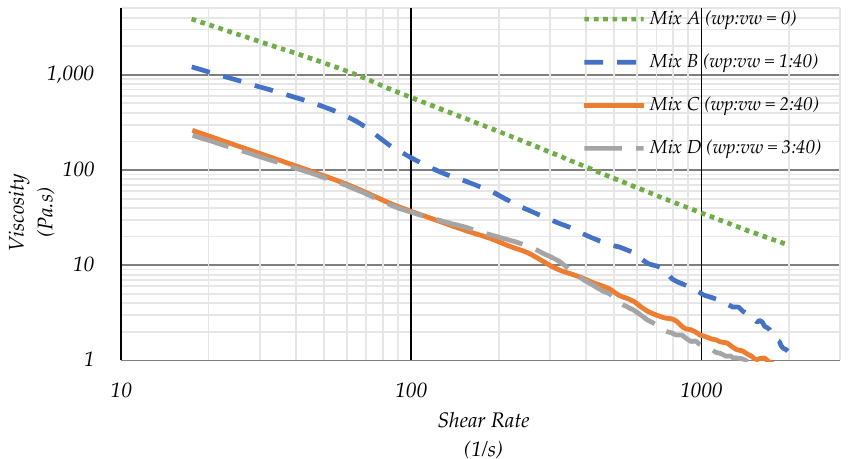
Figure 10. Effects of psyllium husk powder content on the rheological behavior of the biomass– fungi mixtures.